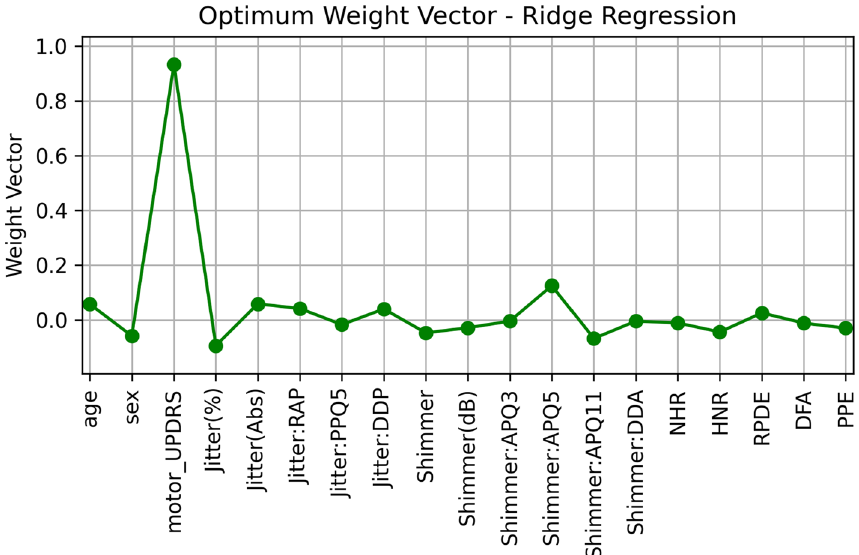
Fig. 20 Optimized weights for Ridge Algorithm